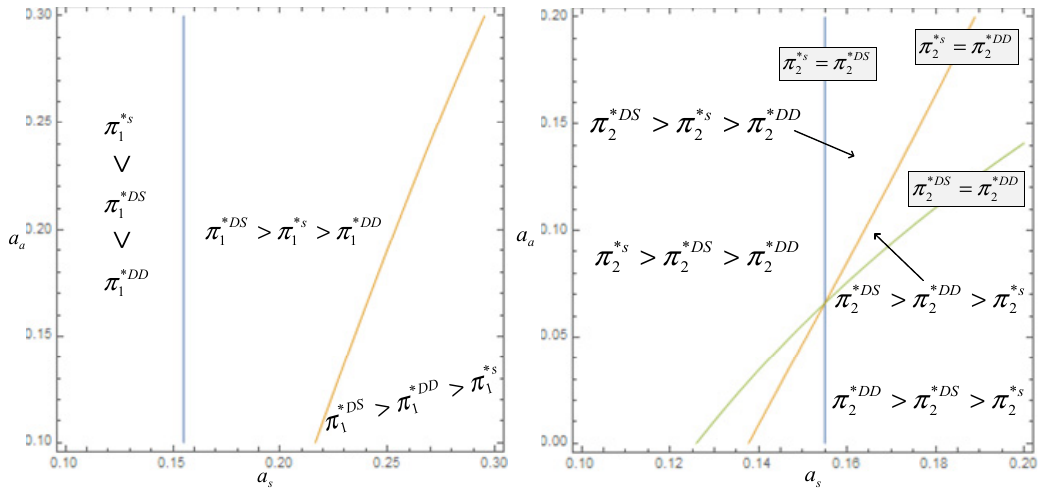
Figure 7. Comparisons of platforms’ profits in three cases.